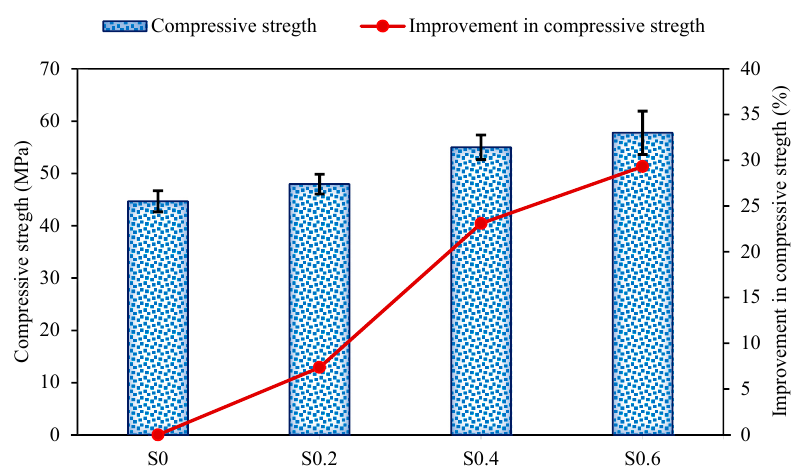
Figure 5. Compressive strength of FR-AASCs.